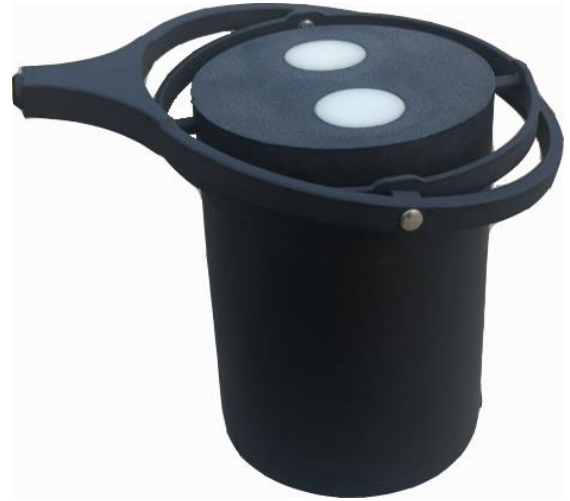
Figure 1. Appearance of the sensor.